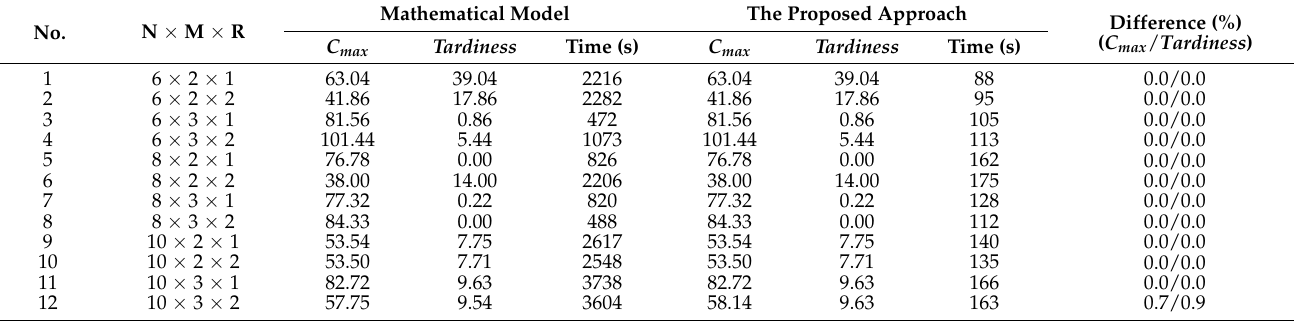
Table 4. Experimental results obtained using small-scale problem test